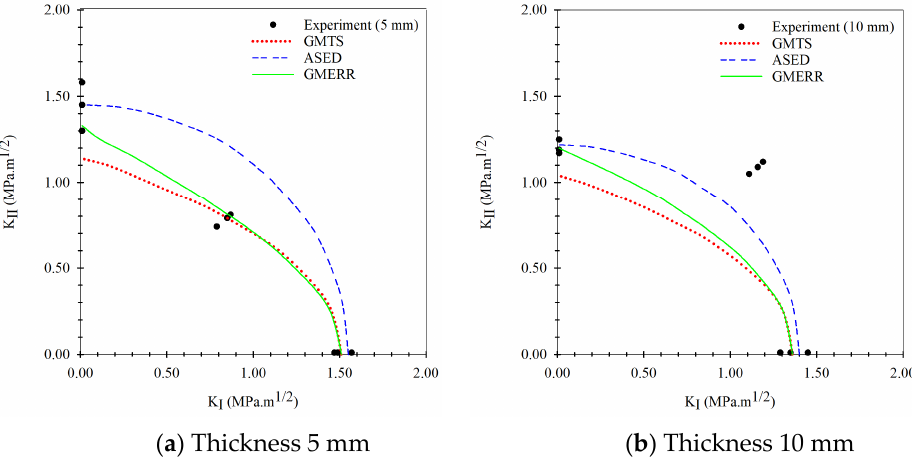
Figure 5. Elementary prediction of mixed-mode I/II fracture toughness of fracture criteria.